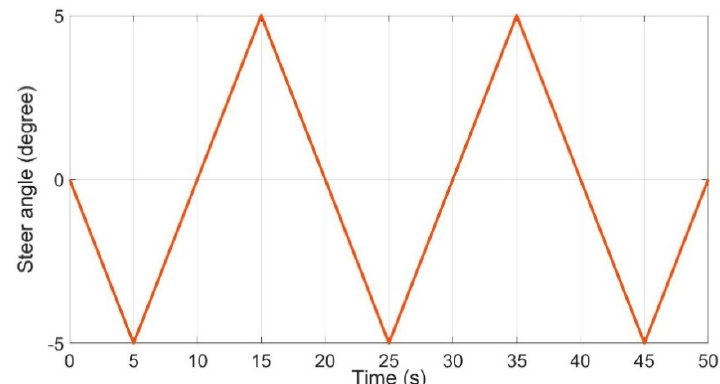
Figure 6. Vehicle steering angle command signal.